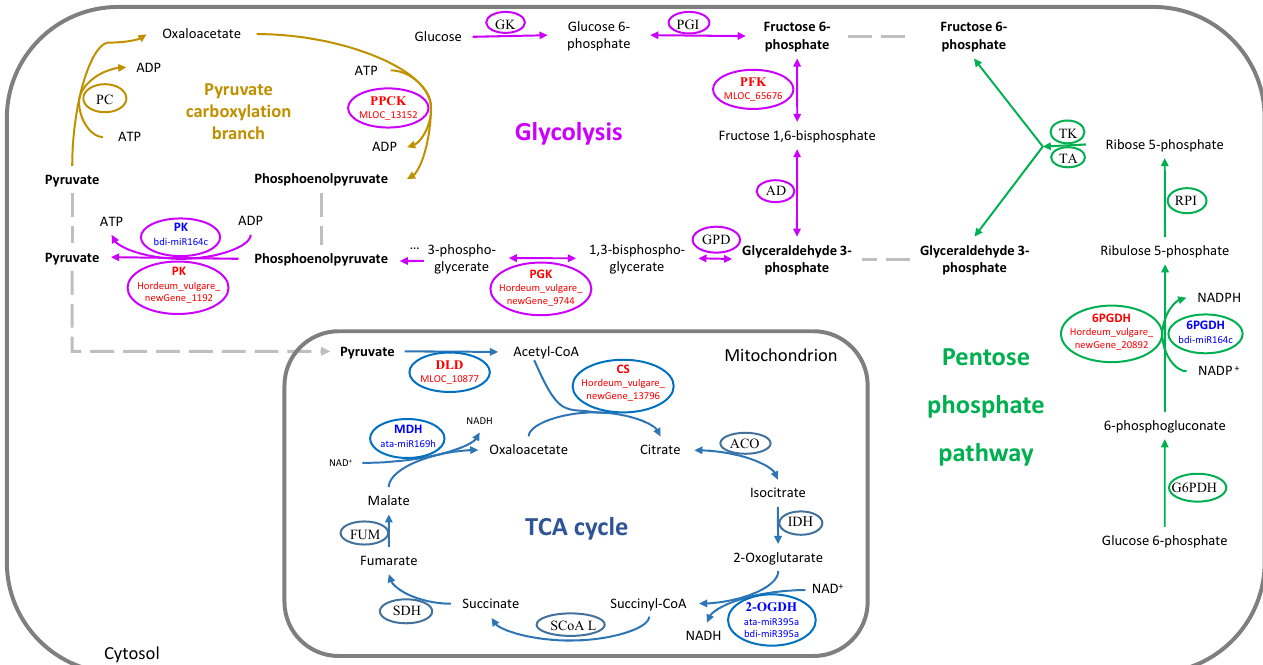
Figure 6. Brief schematic summary of the connections among TCA cycle, glycolysis and pentose phosphate pathway. TCA cycle (blue), tricarboxylic acid cycle: NAD+ is converted to NADH by the 2-OGDH and MDH reactions; CS, citrate synthase; ACO, aconitase; IDH, isocitrate dehydrogenase; 2-OGDH, 2-oxoglutarate dehydrogenase complex; SCoA L, succinyl CoA ligase; SDH, succinate dehydrogenase; FUM, fumarase; MDH, malate dehydrogenase; PDC, pyruvate dehydrogenase com- plex; DC, dicarboxylate carrier. Glycolysis (purple): ADP is converted to ATP by the PK reaction; GK: glucokinase; PGI: phosphoglucose isomerase; PFK: phosphofructokinase-1; AD: aldolase; PK: pyruvate kinase. Pentose phosphate pathway (green): NADP + is converted to NADPH by the 6PGDH reaction; G6PDH: glucose 6-phosphate dehydrogenase; 6PGDH, 6-phosphogluconate de- hydrogenase; RPI: ribose-5-phophate isomerase; TK, transketolase; TA, transaldolase. Pyruvate car- boxylation branch (brown): In gluconeogenesis, PC and PPCK catalyze the conversion of pyruvate from oxaloacetate to phosphoenolpyruvate is known as the pyruvate carboxylation branch. ATP consumption by pyruvate carboxylation pathway is the pathway through which pyruvate bypasses the “energy barrier” to produce phosphoenolpyruvate into gluconeogenesis; PC: pyruvate carbox- ylase; PPCK: phosphoenolpyruvate carboxylase kinase; The enzymes (DEGs) colored in red were detected in this study. The enzymes (miRNAs) colored in blue were detected from Ye et al. (2021). The black bold substances represent the same metabolites which can enter into other metabolic path- ways.